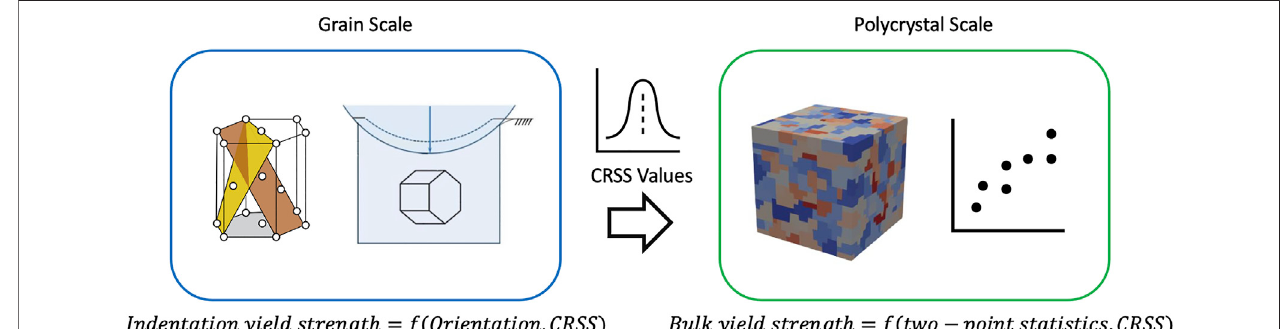
FIGURE 5 | Schematic illustration of the scale-bridging between the response of an individual grain and the response of a polycrystalline aggregate. At the grain scale, the structure-property linkage is formulated to take grain orientation (structure variable) and critical resolved shear strength(s) (CRSS; physics variables) as input and predict the overall property of interest (e.g., indentation yield strength of grains of different orientations). This linkage is used with both experimental and modeling datasets to extract a posterior on the CRSS for a given material system (see Panel 6 for more details). At the polycrystal scale, the structure-property linkage is formulatedtotakethe2-pointspatialcorrelationsoforientation(structurevariables)andCRSS(physicsvariables)tomakeapredictionofthebulk(effective)yieldstrength of the polycrystal (c.f., Paulson et al., 2017).